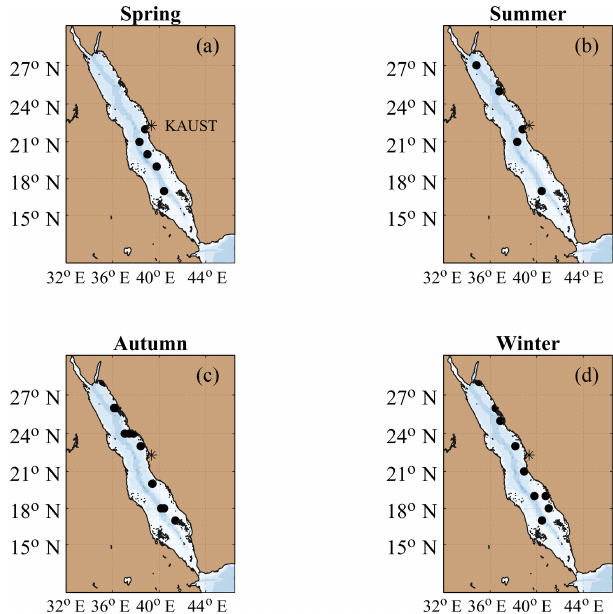
Figure 1. Stations sampled along the Red Sea during (a) spring 2018, (b) summer 2018, (c) autumn 2016, and (d) win- ter 2016 and